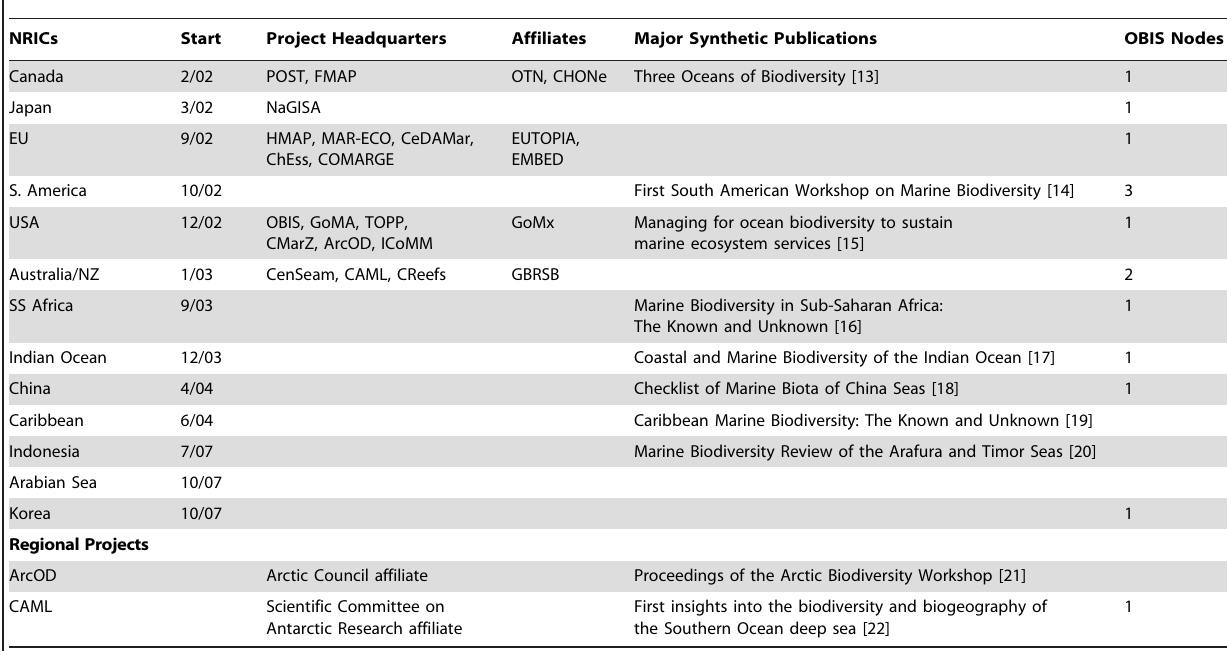
Table 1. Summary of regional activities contributing to the globalization of the Census of Marine